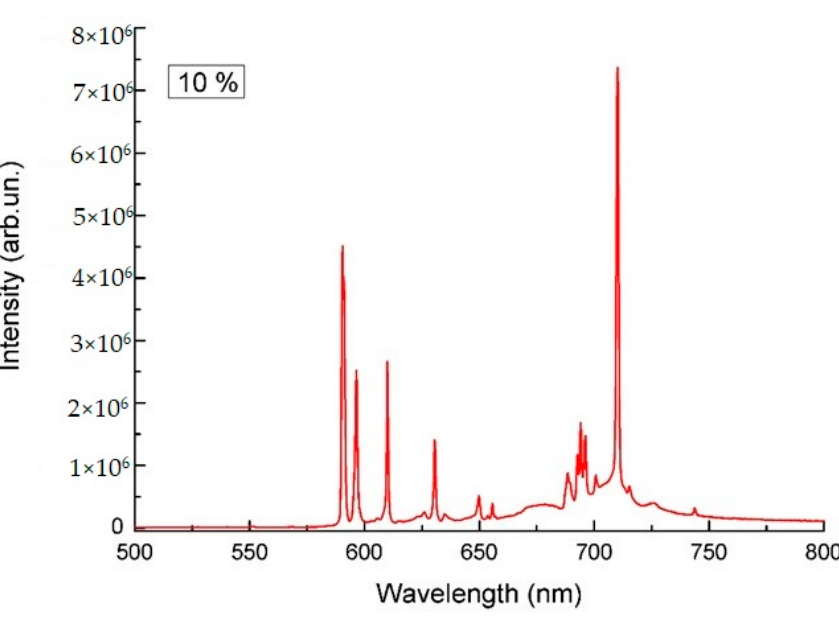
Figure 13. The photoluminescence spectra of YAG:Eu (10%).